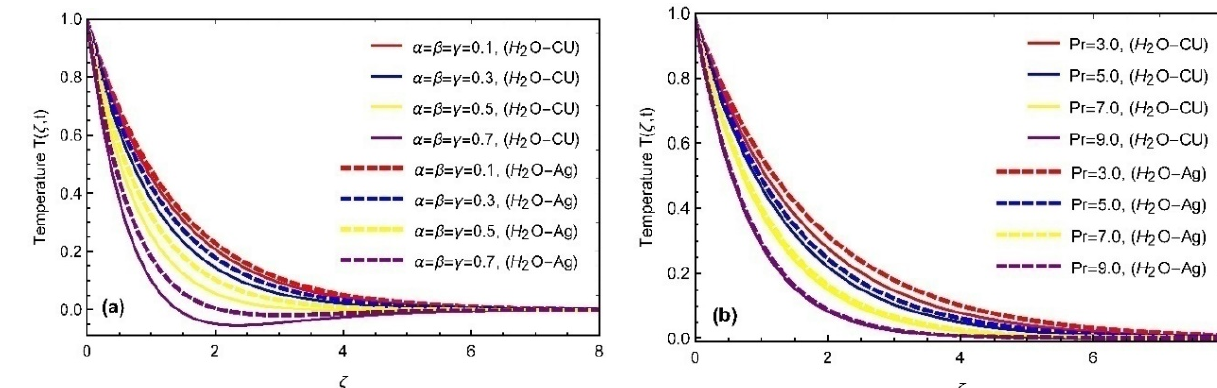
Figure 3. Temperature profiles for ( a ) α , β , γ and ( b ) Pr with ϕ = 0.02, t = 1.0.